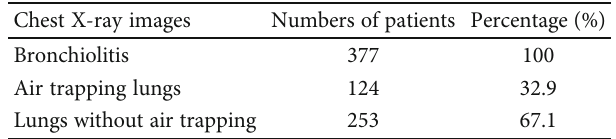
Figure 1: Monthly distribution of bronchiolitis patients in a one-year period. Table 6: Chest X-ray of children with acute bronchiolitis caused by Table 4: The admission reasons of children with acute RSV ( N = 377 ). bronchiolitis caused by RSV ( N = 377 ).